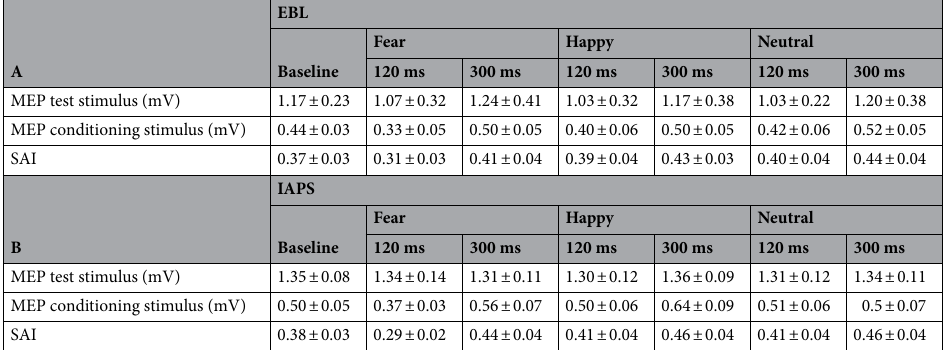
Table 1. MEPs and SAI data in the main experiment. In the table, MEPs values for the Test and Conditioning stimuli and SAI data are reported for EBL (A) and IAPS (B). All values are reported as mean ± standard error of the mean